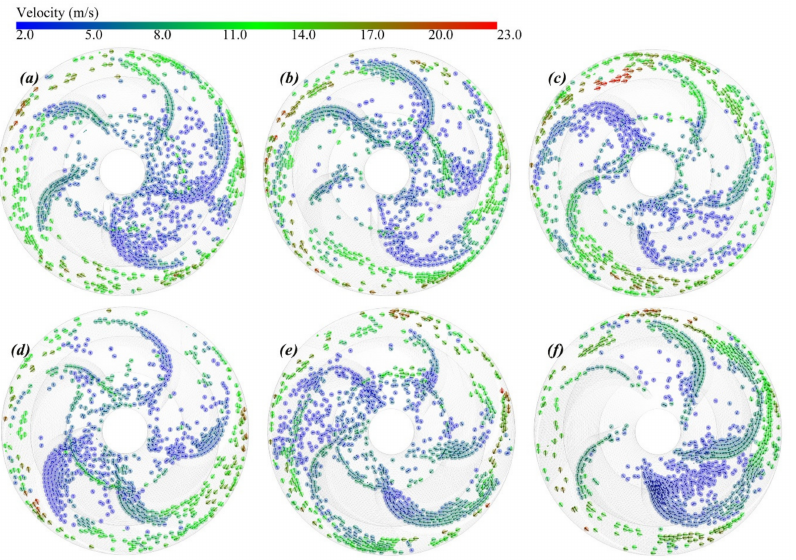
Figure 12. Particle distribution in diffusers of six-stage centrifugal pump at 420 m 3 /h and 1450 rpm: ( a ) first stage; ( b ) second stage; ( c ) third stage; ( d ) fourth stage; ( e ) fifth stage; ( f ) sixth